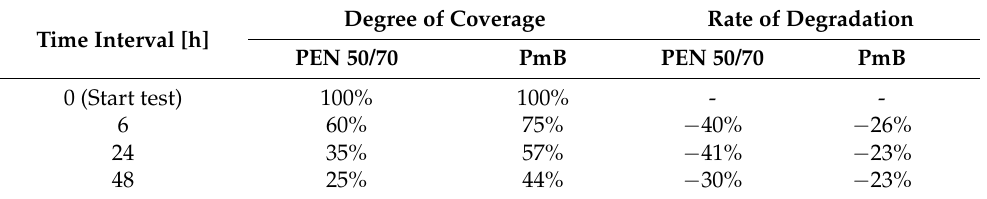
Table 3. Results of rolling bottle test on steel slag aggregates and the considered bituminous binders. Degree of Coverage Rate of Degradation Time Interval [h] PEN 50/70 PmB PEN 50/70 PmB 0 (Start test) 100% 100% -